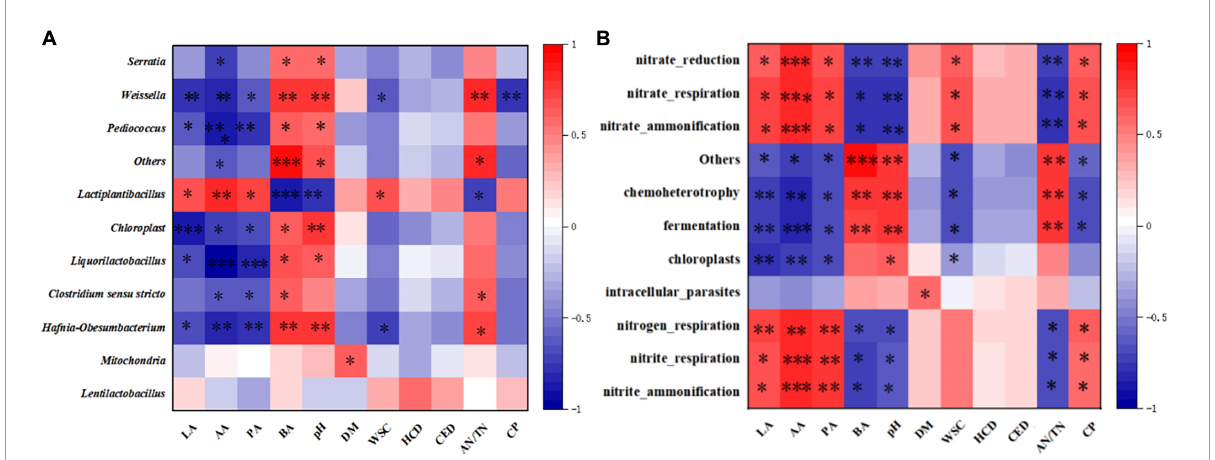
FIGURE4 Heatmap of the Spearman correlation coefficients between dominant bacterial species (A) / predicted functions (B) and silage fermentation parameters on day 60. The correlations that are positive (closer to 1) have red squares, whereas those that are negative (closer to –1) have blue squares between the taxa and production parameters. Heatmap of the Spearman correlations between function prediction and silage fermentation parameters on day 60. Correlations that are positive (closer to 1) have red squares, whereas those that are negative (closer to –1) have blue squares between the taxa and production parameters. LA, lactic acid; AA, acetic acid; PA, propionic acid; BA, butyric acid; DM, dry matter; WSC, water-soluble carbohydrates; HCD, hemicellulose degradation rate; CED, cellulose degradation rate; AN/TN,